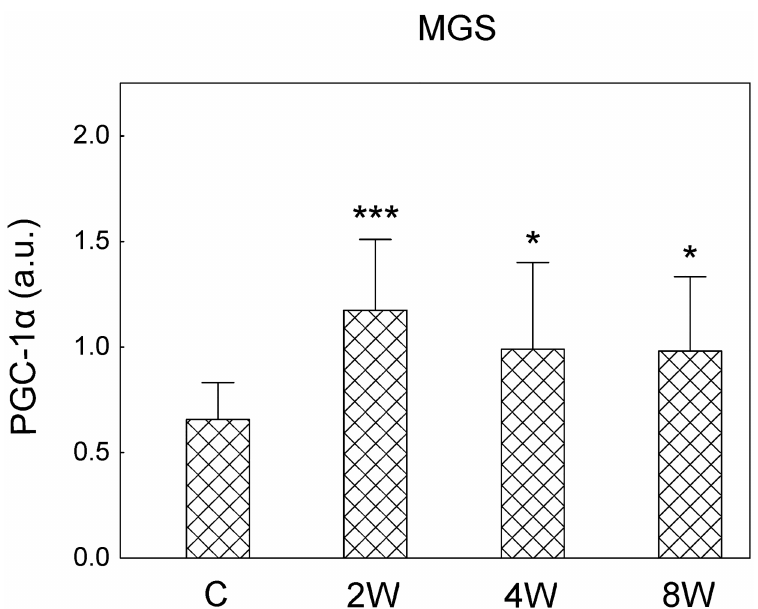
Fig 9. PGC-1 α in the MGS in control and trained animals. PGC-1 α in the slow part of the medial gastrocnemius (MGS, S14 File) after 2, 4 and 8 weeks of endurance training. Data are presented as mean + SD and normalized by the reference protein GAPDH and the internal standard. One-sided p-value represents the statistical significance of the training period (2, 4 or 8 weeks) with respect to the control group (Dunnett’s post hoc test). The symbols (cid:3) denote values significantly different: (cid:3) p < 0.05, (cid:3)(cid:3) p < 0.01, (cid:3)(cid:3)(cid:3) p < 0.001.